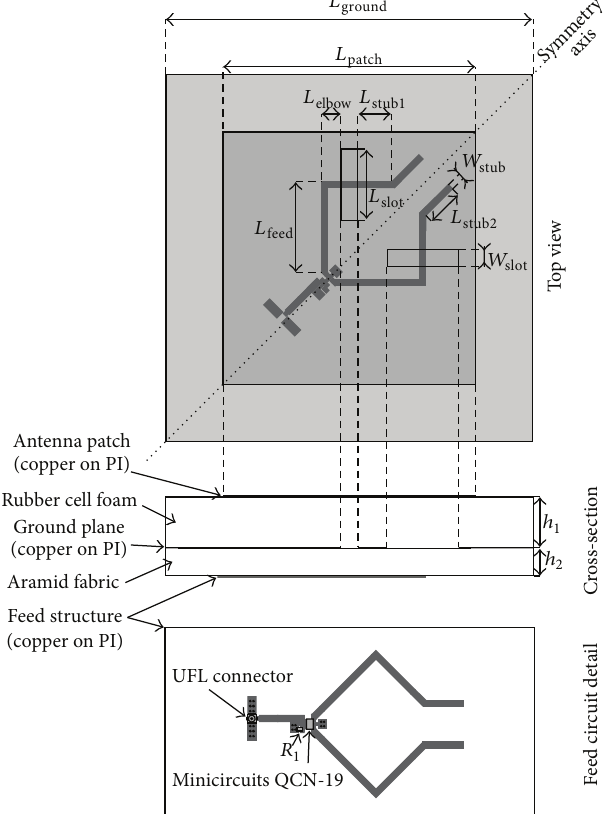
Figure 1: Topology of the E6-band Galileo